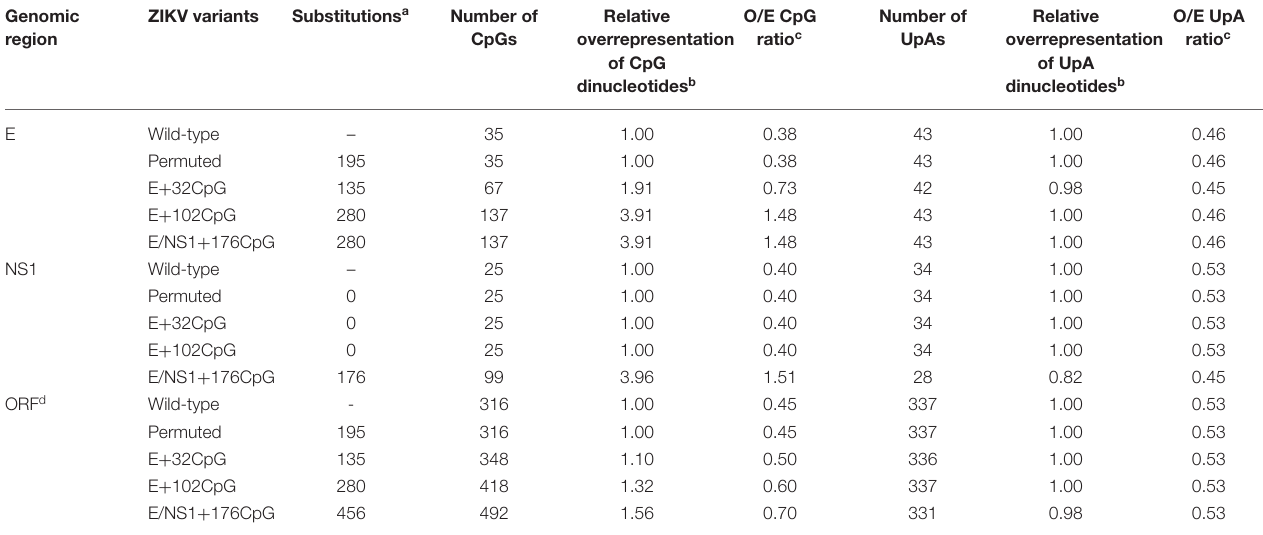
TABLE 1 | CpG and UpA dinucleotide composition in ZIKV variants. Genomic ZIKV variants Substitutions a Number of region